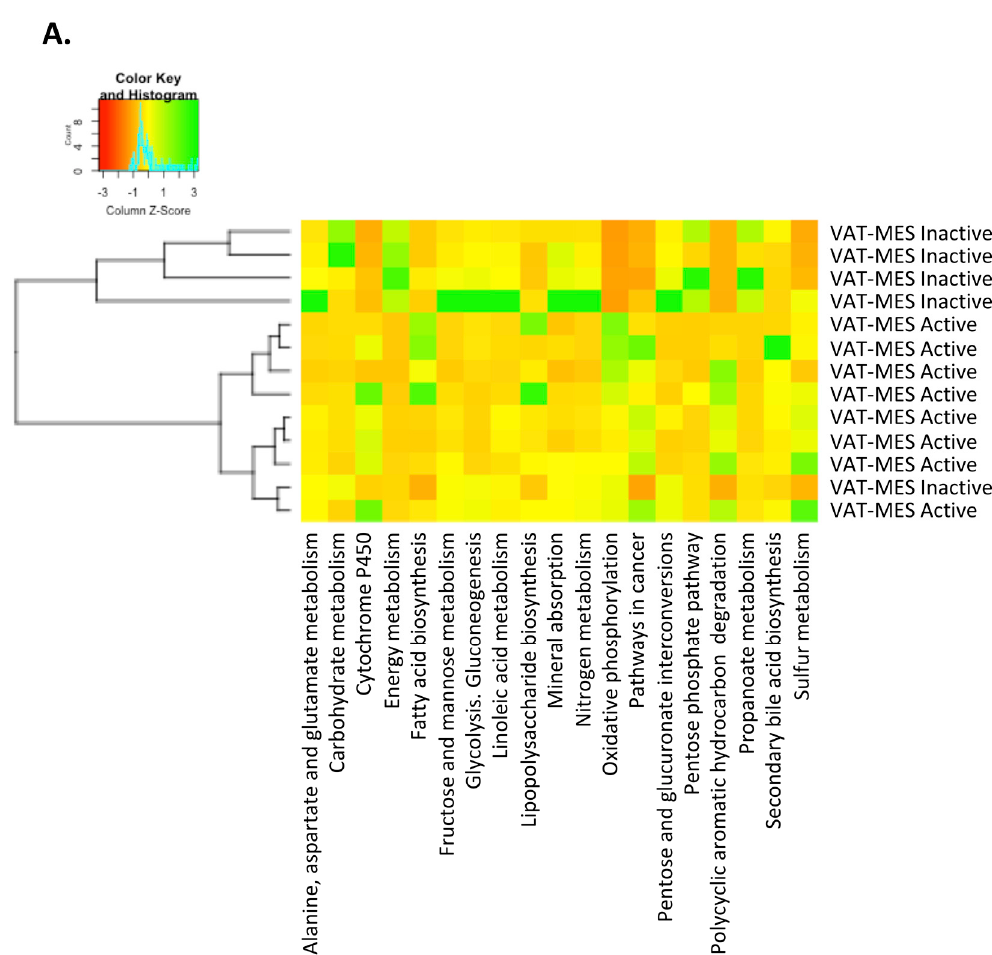
Figure 3. The inferred functional content of gut microbiota in visceral adipose tissue depends on the clinical status of the patients. ( A ) Heat map of functional content in mesenteric-visceral adipose tissue from patients with active and inactive Crohn’s disease was predicted by inferred PICRUSt analysis. p -values are corrected for multiple comparisons using the Benjamini–Hochberg method.